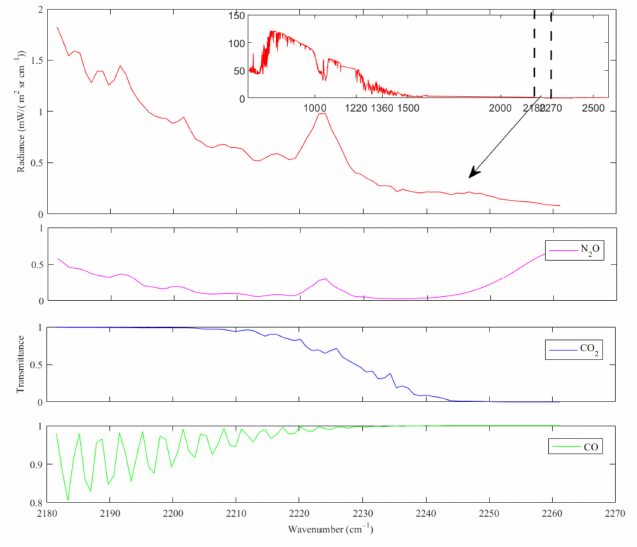
Figure 4. A segment of the AIRS spectrum near the υ 3 absorption band of N 2 O (top plot) and the transmittances of N 2 O, CO 2 , and CO (bottom three plots) in the SIR range.